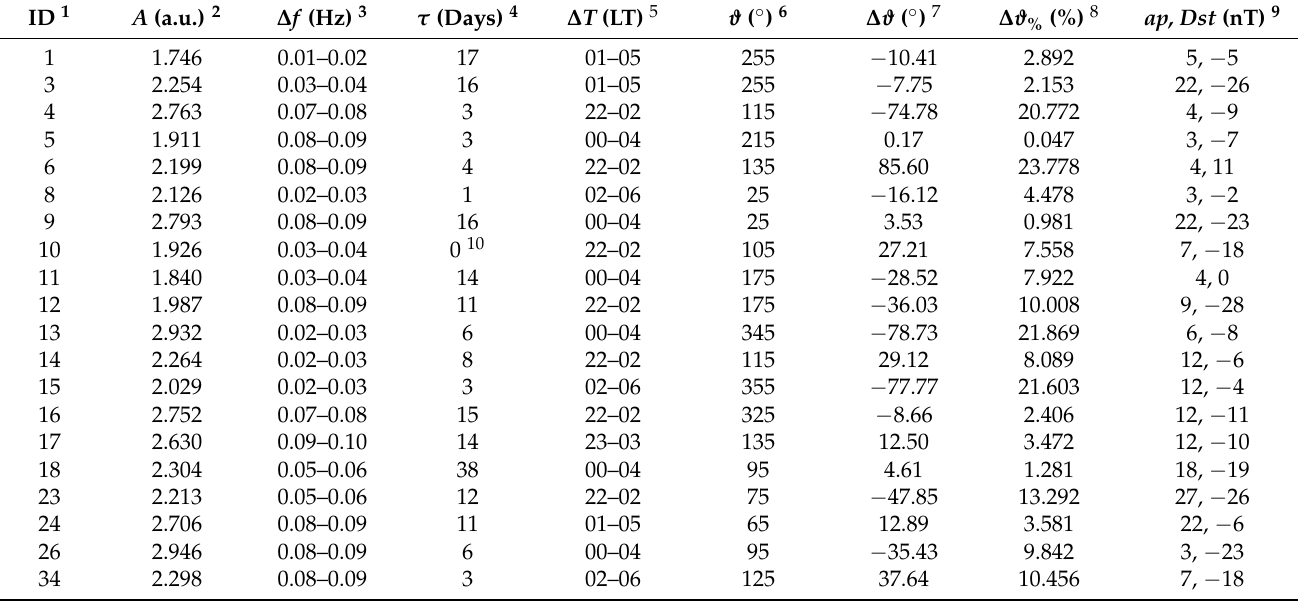
Table 3. Characteristics of found